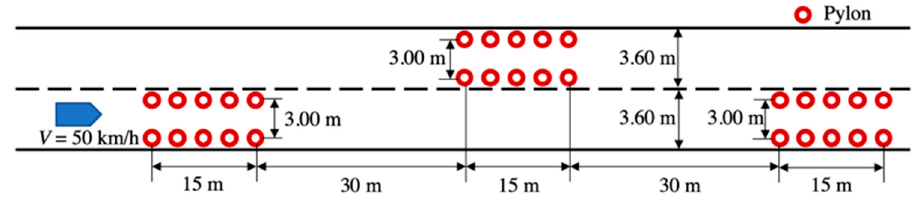
Figure 2. Experimental driving scenario performed in the driving simulator.